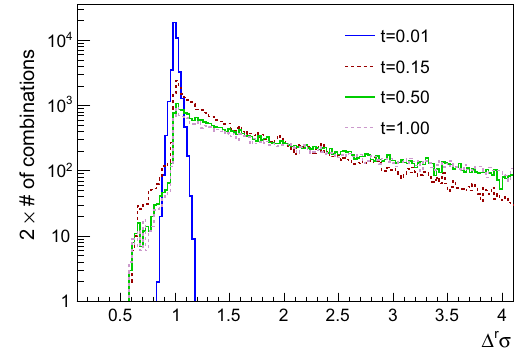
Fig. 11 Ratio of the uncertainties on ¯ x obtained with the method described in this document and using a direct likelihood combination, shown for different values of the threshold t for systematic uncertain-